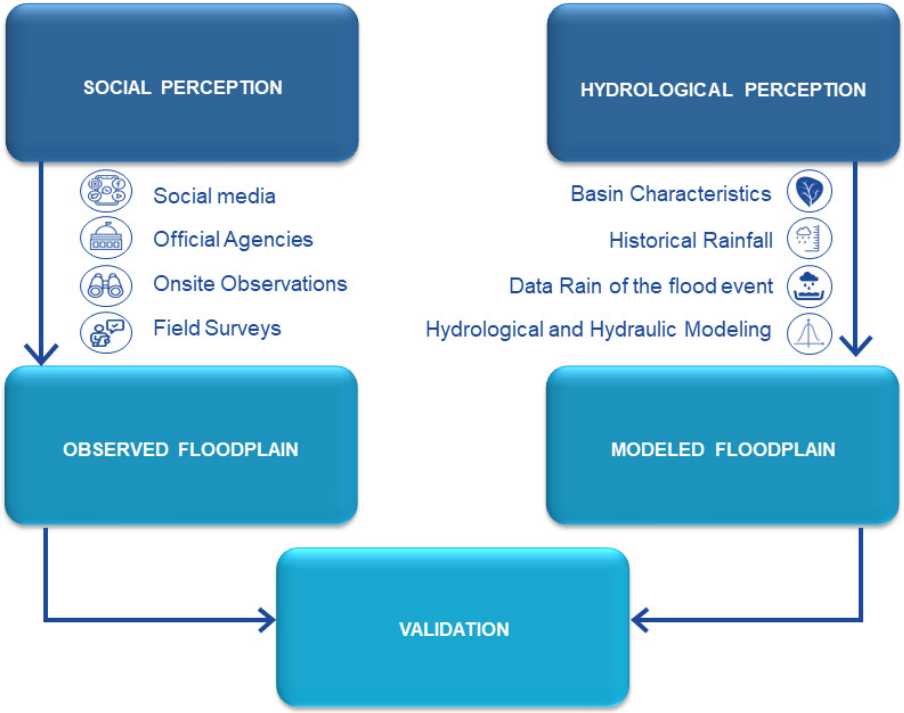
Figure 1. Summary of the proposed